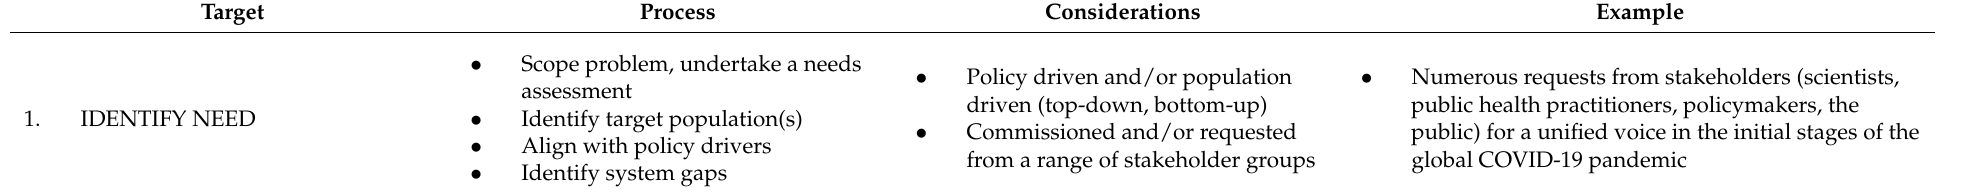
Table 1. Summary of the Template for Rapid Iterative Consensus of Experts (TRICE) and examples of the use of TRICE during the COVID-19 pandemic.